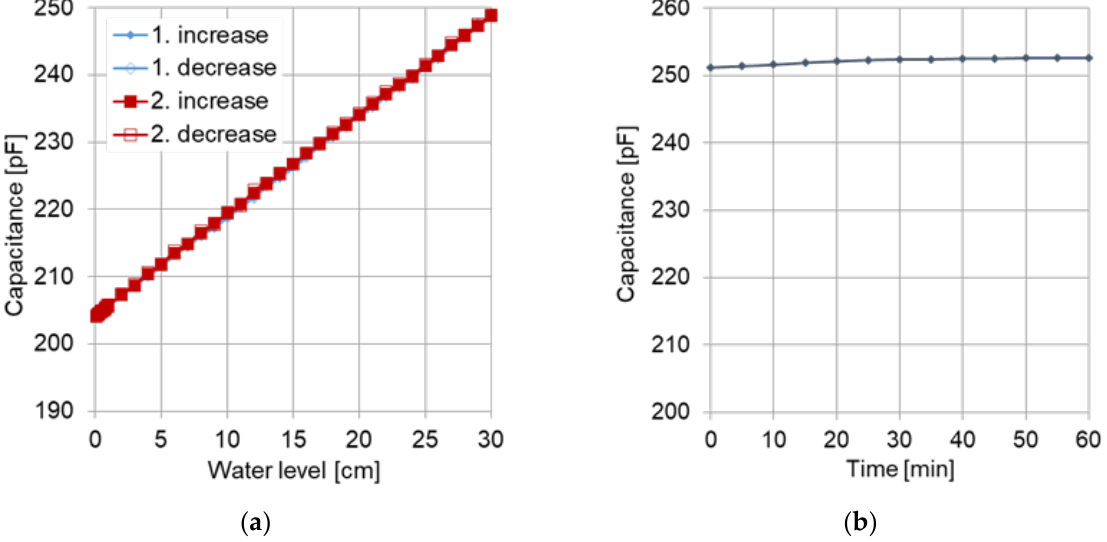
Figure 14. Measured capacitance of an out-of-plane DE strain sensor upon increase and decrease in the water level in the tube above the sensor in two cycles ( a ) and measured capacitance at 30 cm water level in the tube over 60 min ( b ) [102].